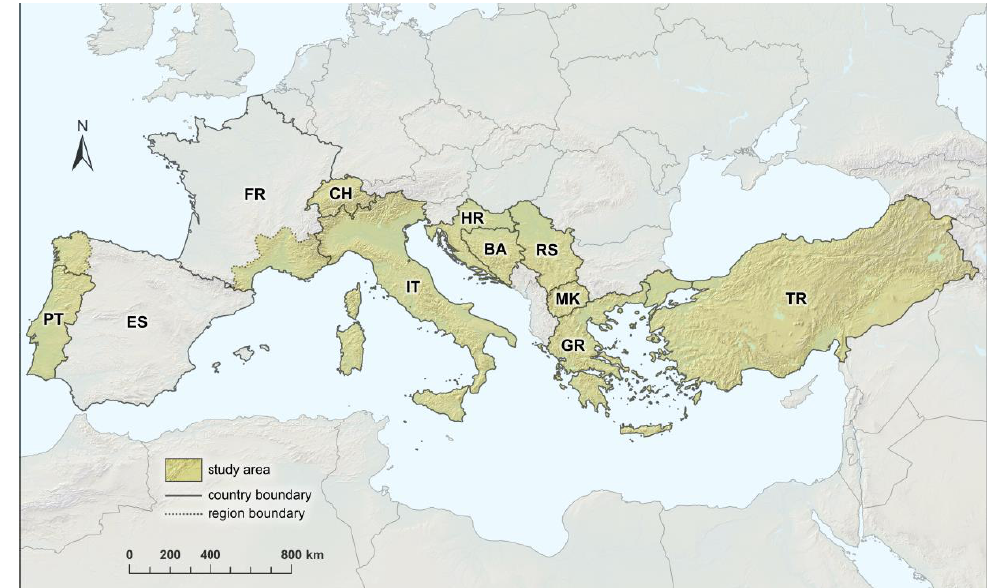
Figure 1. Study area with the countries involved (PT = Portugal, ES = Spain, FR = France, IT = Italy, CH = Switzerland, HR = Croatia, BA = Bosnia and Herzegovina, RS = Serbia, MK = Republic of North Macedonia, GR = Greece, TR = Turkey). Shaded areas represent the reference regions of the